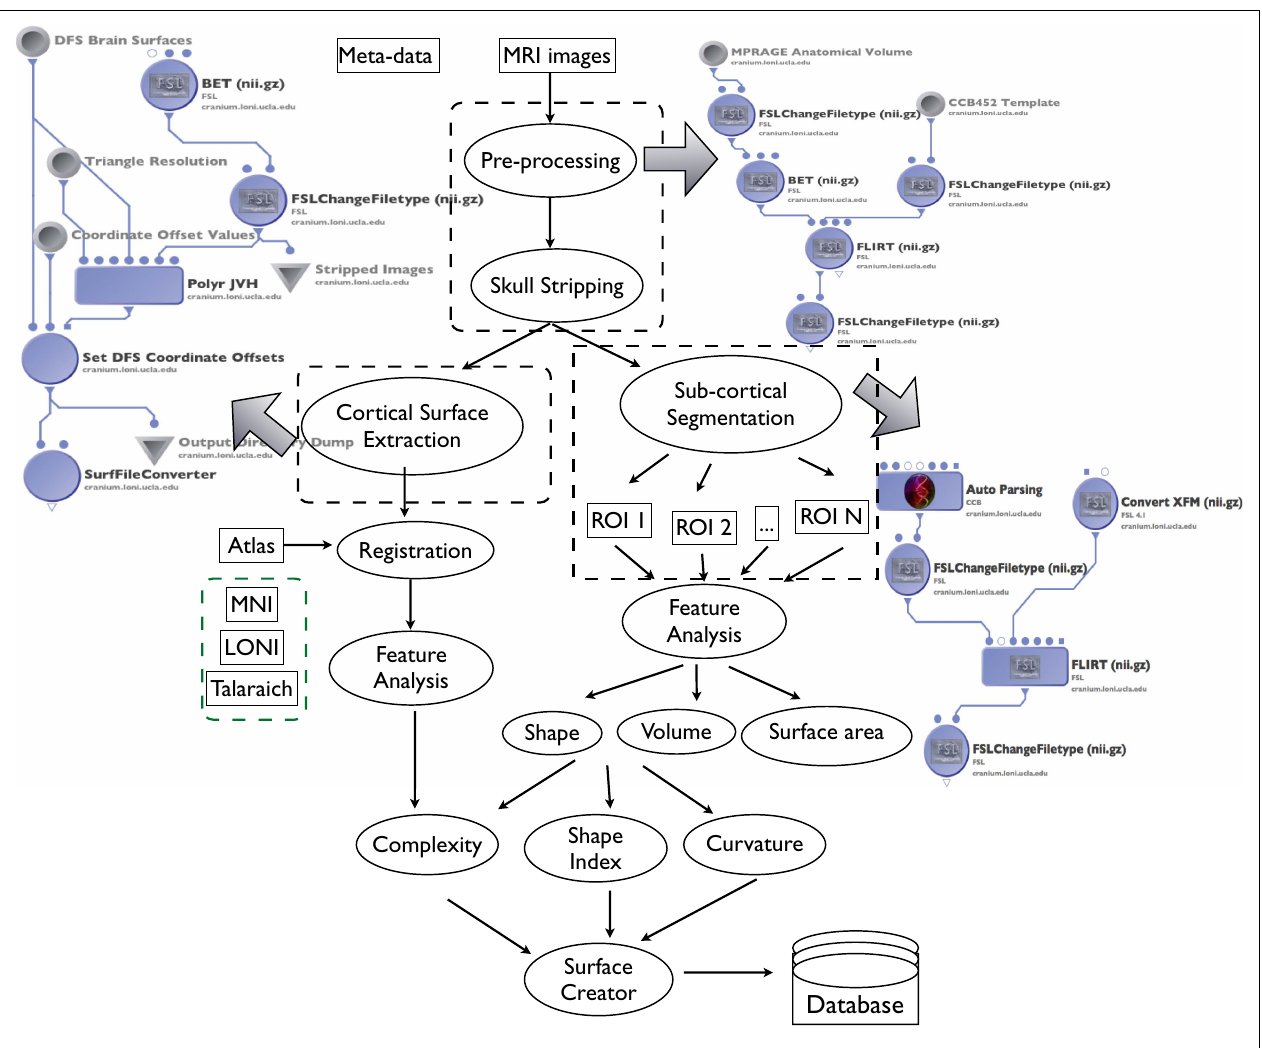
FIGURE1 | A schematic of the data mining workfl ows exposed through the LONI pipeline (Rex et al., 2003). The workfl ow is divided into three parts, i) Processing, ii) Feature Extraction – extracting anatomical features such as cortical surfaces, sub-cortical structures etc. and having 3D mesh